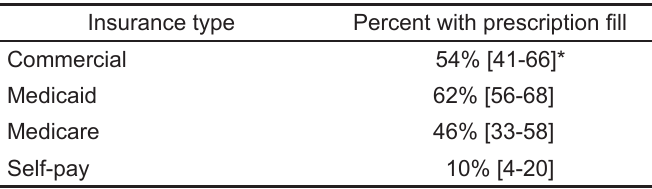
Difference between fill rates and insurance type P<.01. *Data is presented as the percent with the 95% confidence interval in